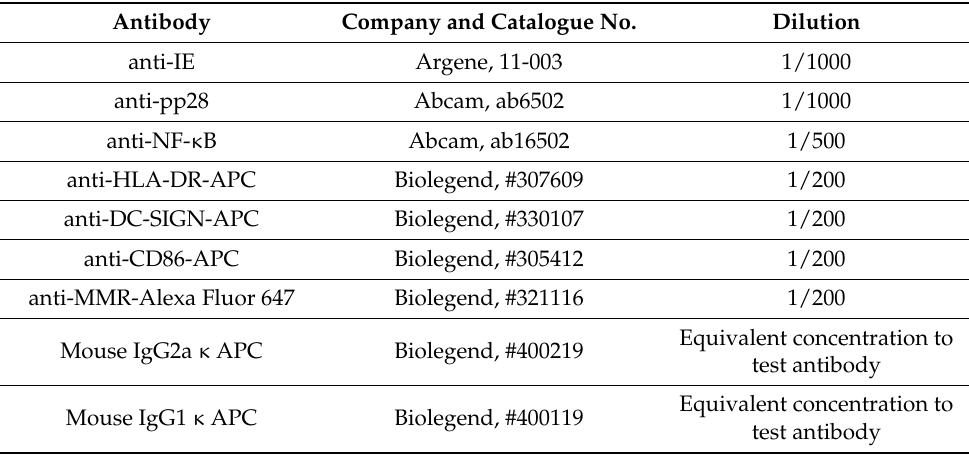
Table 1. List of antibodies used in immunofluorescence